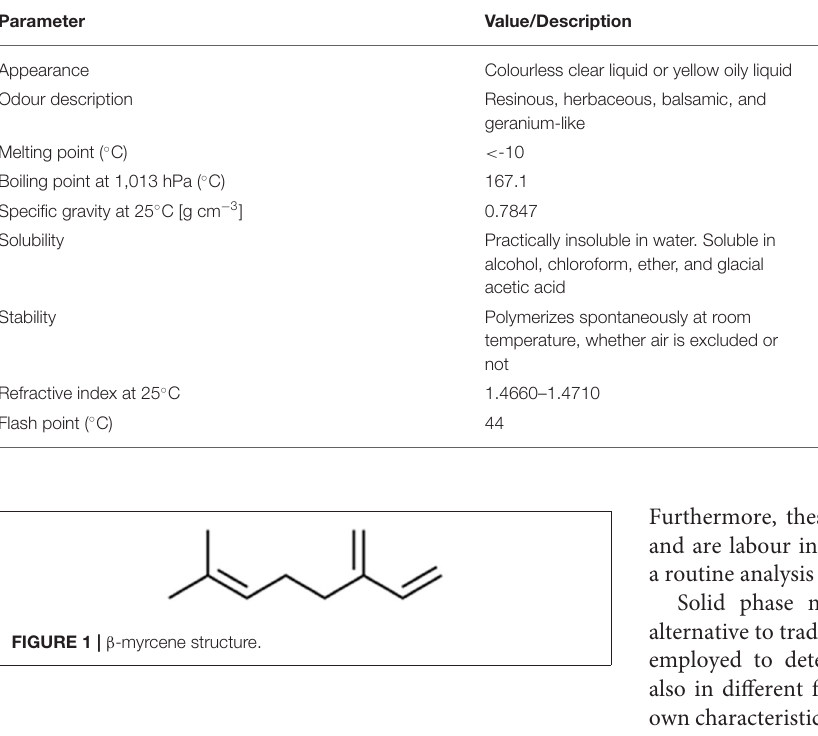
TABLE 1 | Chemical and physical properties of β -myrcene.